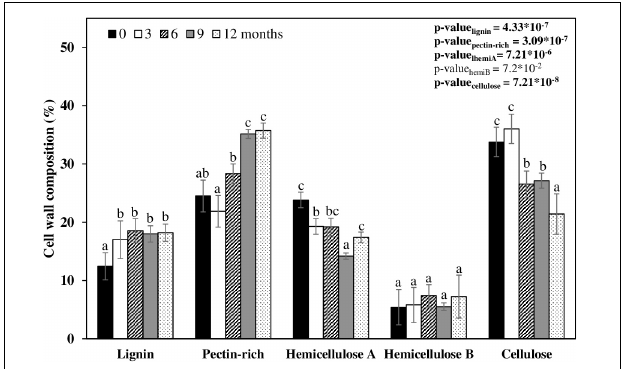
FIGURE 3 | Relative percentages of cell wall composition of sugarcane straw for 12 months. Each bar represents the percentage of the component in the cell wall of each day sampled. A table with the values and statistics is in Supplementary Table 1 ( n = 5).